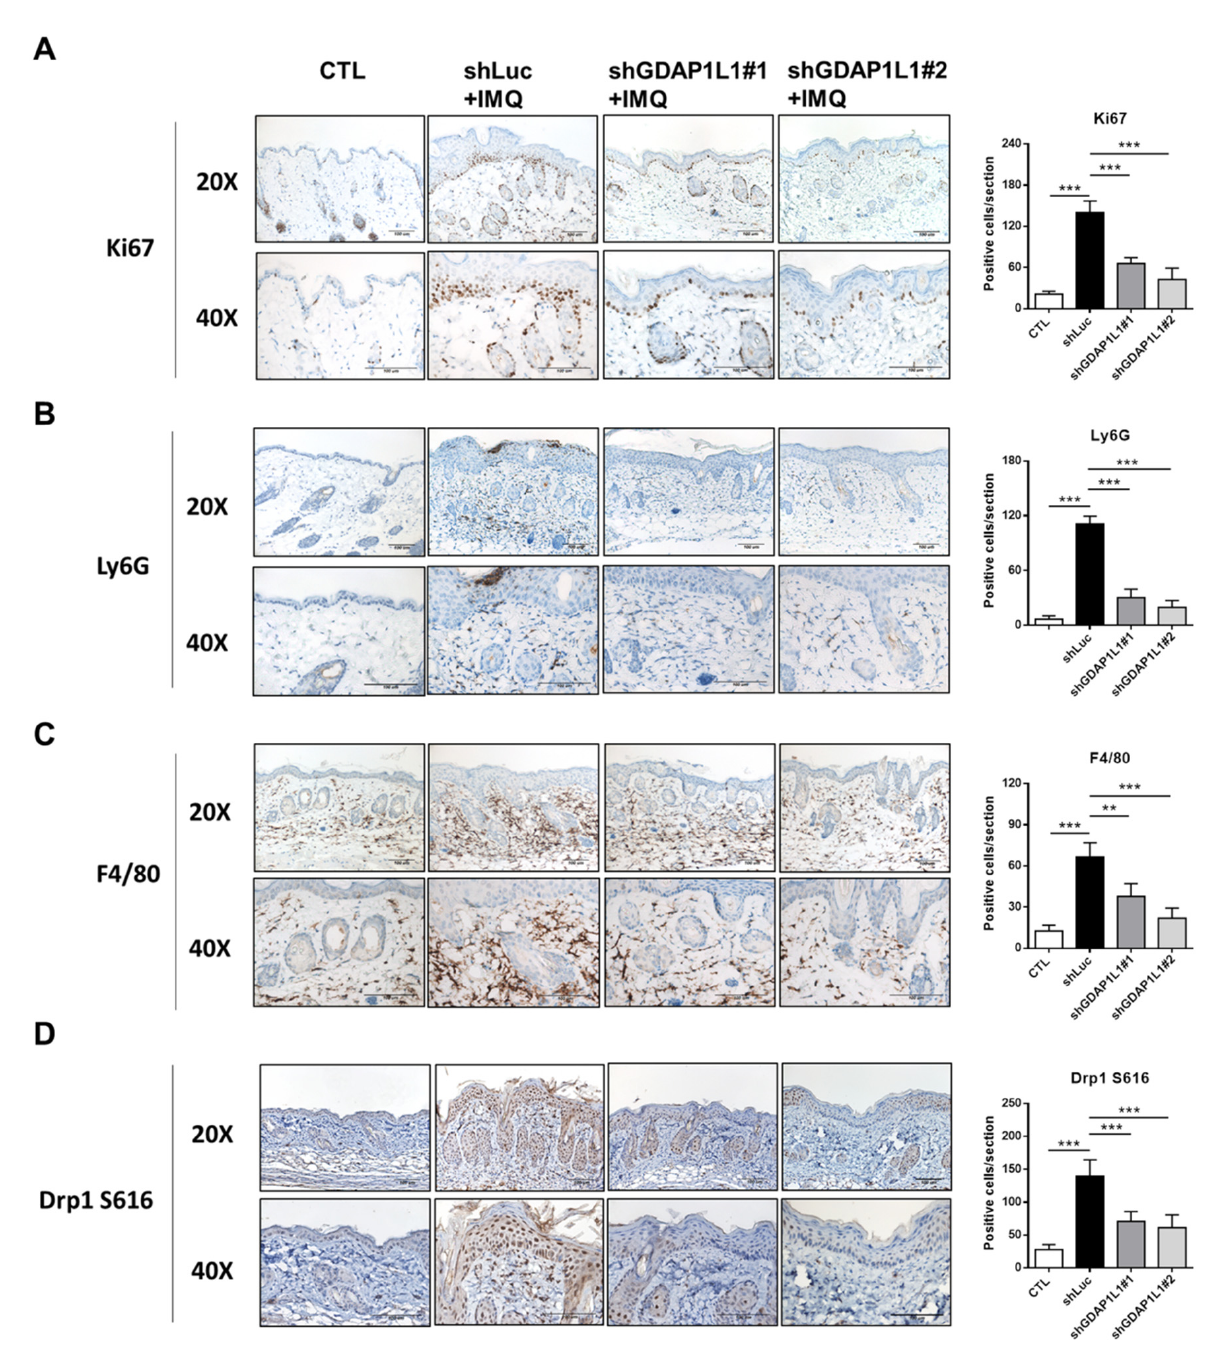
Figure 6. Loss of GDAP1L1 ameliorated histological changes of IMQ-induced psoriasis-like inflammation. Immunohis- tochemical detection of ( A ) Ki67, ( B ) Ly6G, ( C ) F4/80, and ( D ) Drp1 S616 expression in dorsal skin from the control or GDAP1L1-deficient THP1 macrophage transplantation mice with or without IMQ on Day 6. Quantitative analysis of the indicated markers in the skin ( n = 5) is presented in the right panel. ** p < 0.01 and *** p < 0.001 when compared to shLuc group. Data are represented as mean ± SEM. Scale bar, 100 μ m.